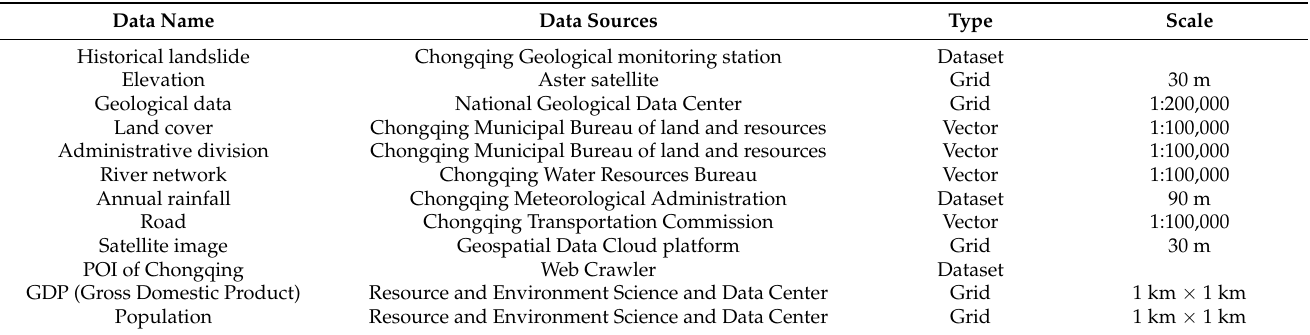
Table 1. Data and data sources.